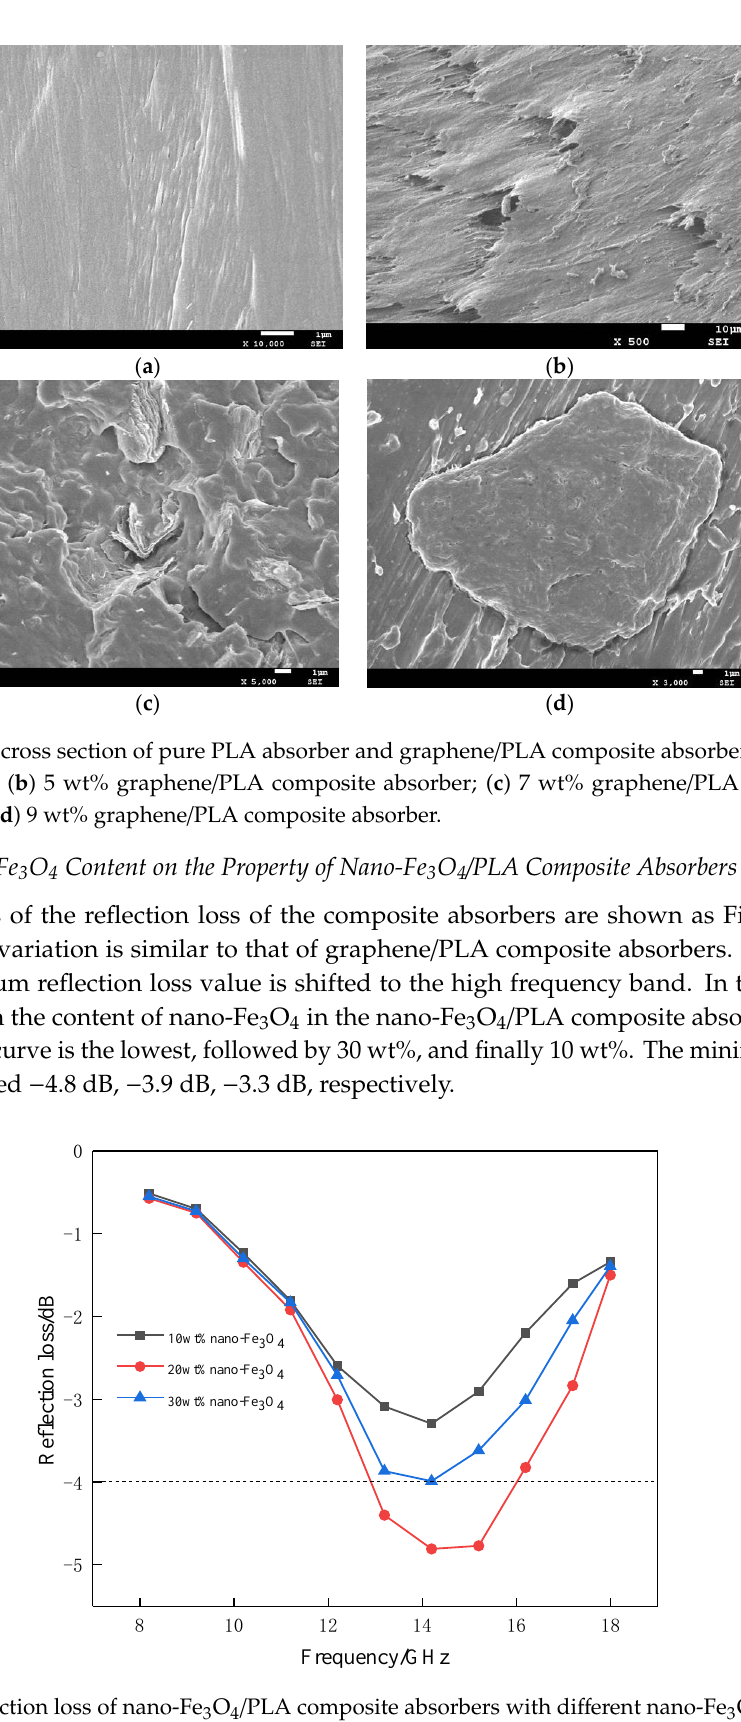
Figure 4. Reflection loss of nano-Fe 3 O 4 / PLA composite absorbers with di ff erent nano-Fe 3 O 4